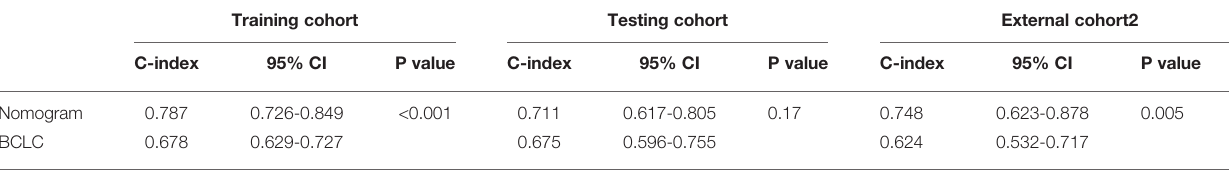
TABLE 4 | C-index of the nomogram and BCLC staging system for OS.